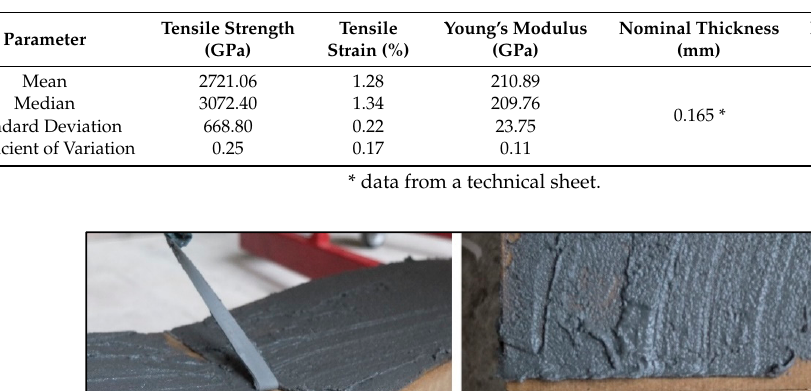
Table 1. Carbon Fiber ‐ Reinforced Polymer (CFRP) characteristics.